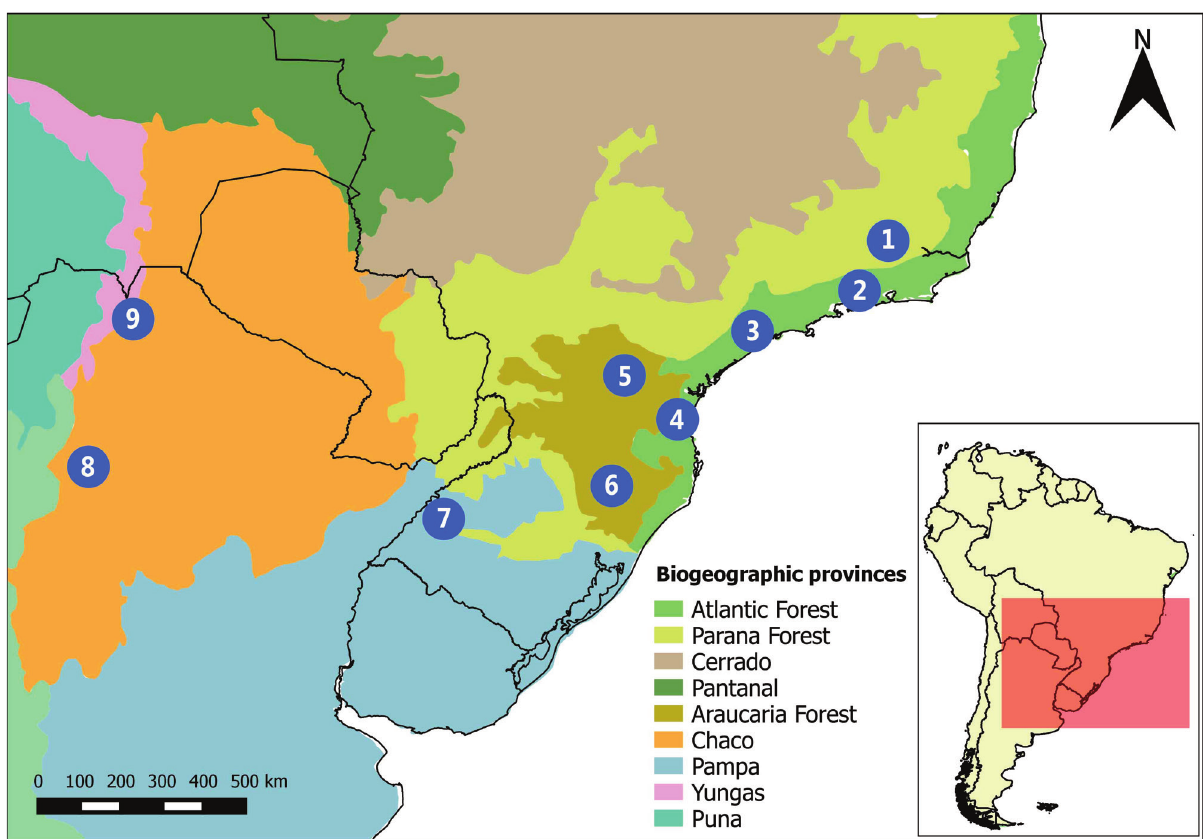
Figure 2. Geographic groups of Penelope obscura separated by biogeographic provinces: Parana forest (1), Atlantic Forest (2,3,4), Araucaria Forest (5,6), Pampa (7), Chaco (8) and Yungas